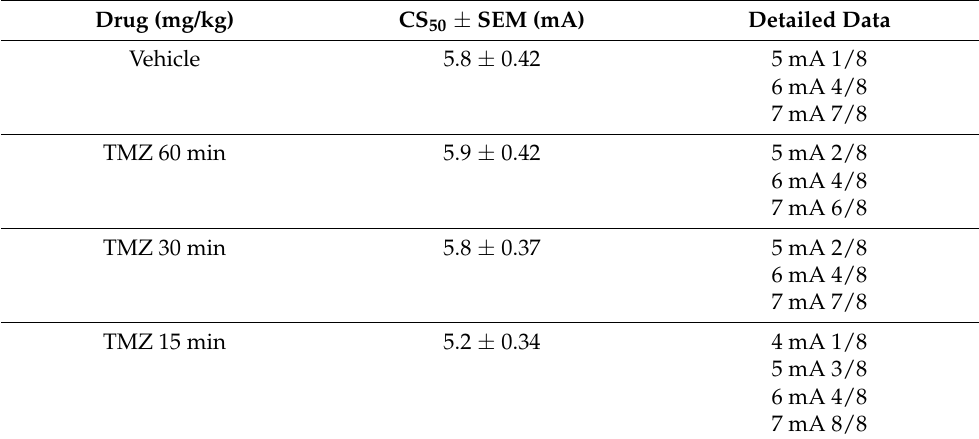
Table 1. Effect of trimetazidine (40 mg/kg), applied at different time points, on the electroconvulsive threshold in mice.